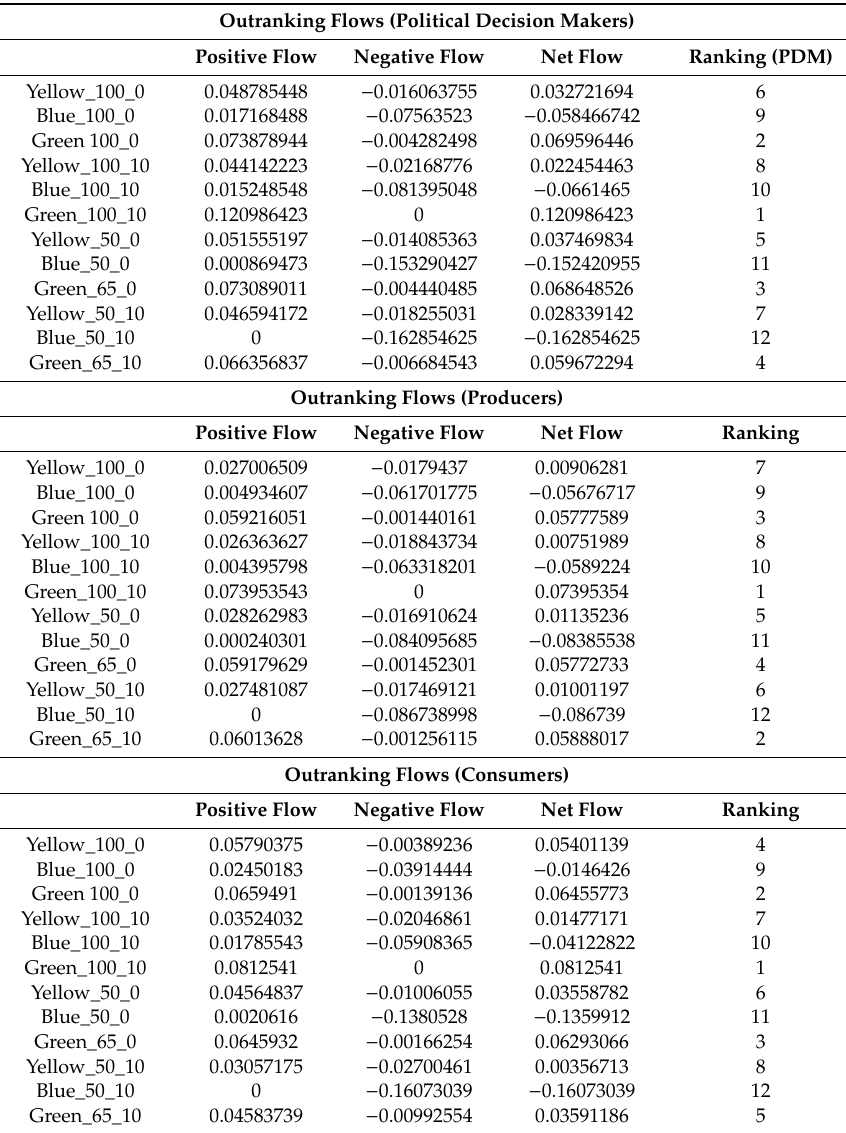
Table A4. Outranking flow